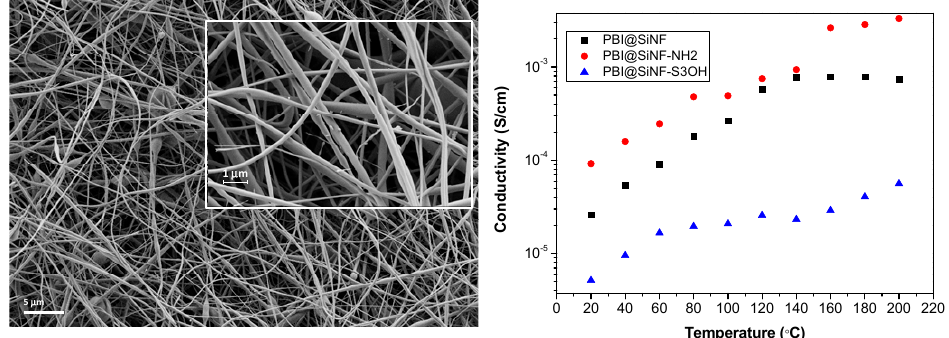
Figure 26. FE-SEM images of SiO 2 nanofibers and temperature dependence of composite PBI membranes with neutral (PBI@SiNF), basic (PBI@SiNF–NH 2 ), and acidic groups (PBI@SiNF–SO 3 H) [76]. Table 11. Nanofibers polybenzimidazole derivates.